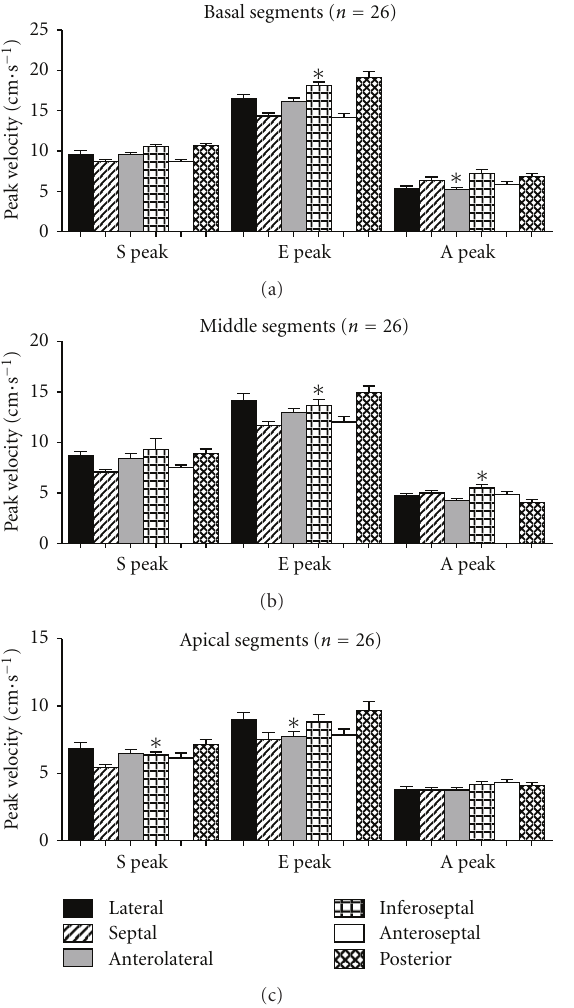
Figure 4: Tissue Doppler values during exercise for systolic (a), early diastolic (b), and late diastolic velocities (c). Septal is septal basal segment, lateral is the lateral basal segment, and radial is the inferobasal segment measured in the short axis. ∗ P < . 001. P values are determined for the comparison of values from basal to apical segments using repeated measures ANOVA for within subject di ff erence with Greenhouse-Geisser